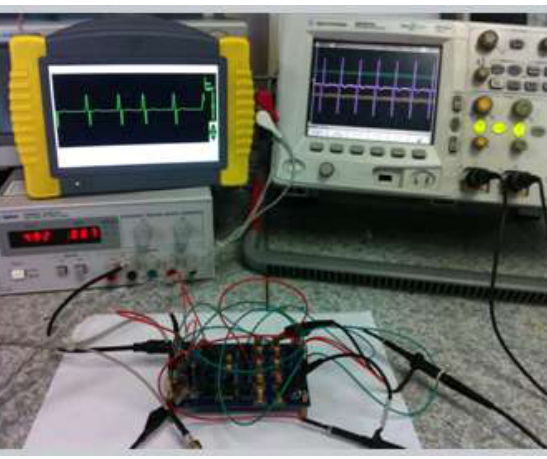
Figure 8 .the output result of the chip with the ECG